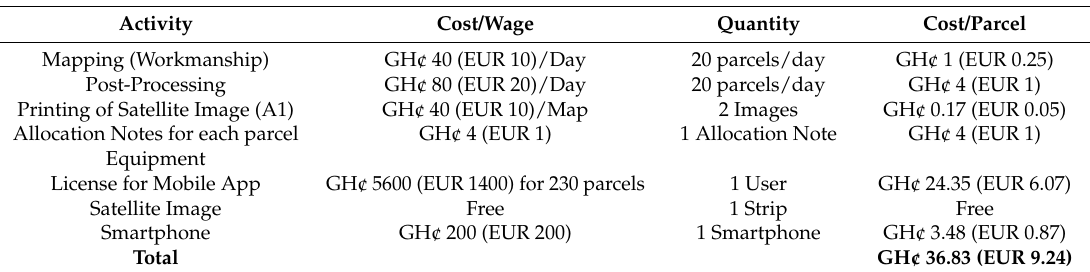
Table 3. Breakdown of the Cost of the Mapping